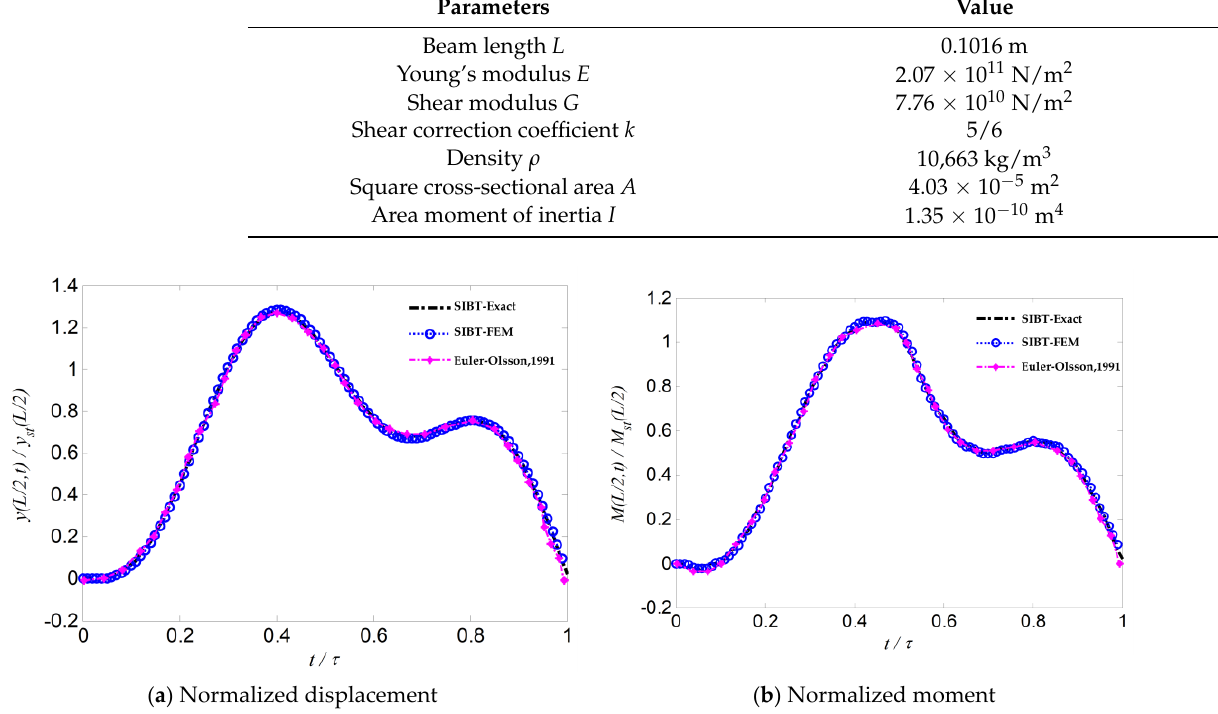
Figure 9. Mid-span displacement and bending moment of beam with c = 0.25. Table 3. D 1 and D 2 for different moving speeds.